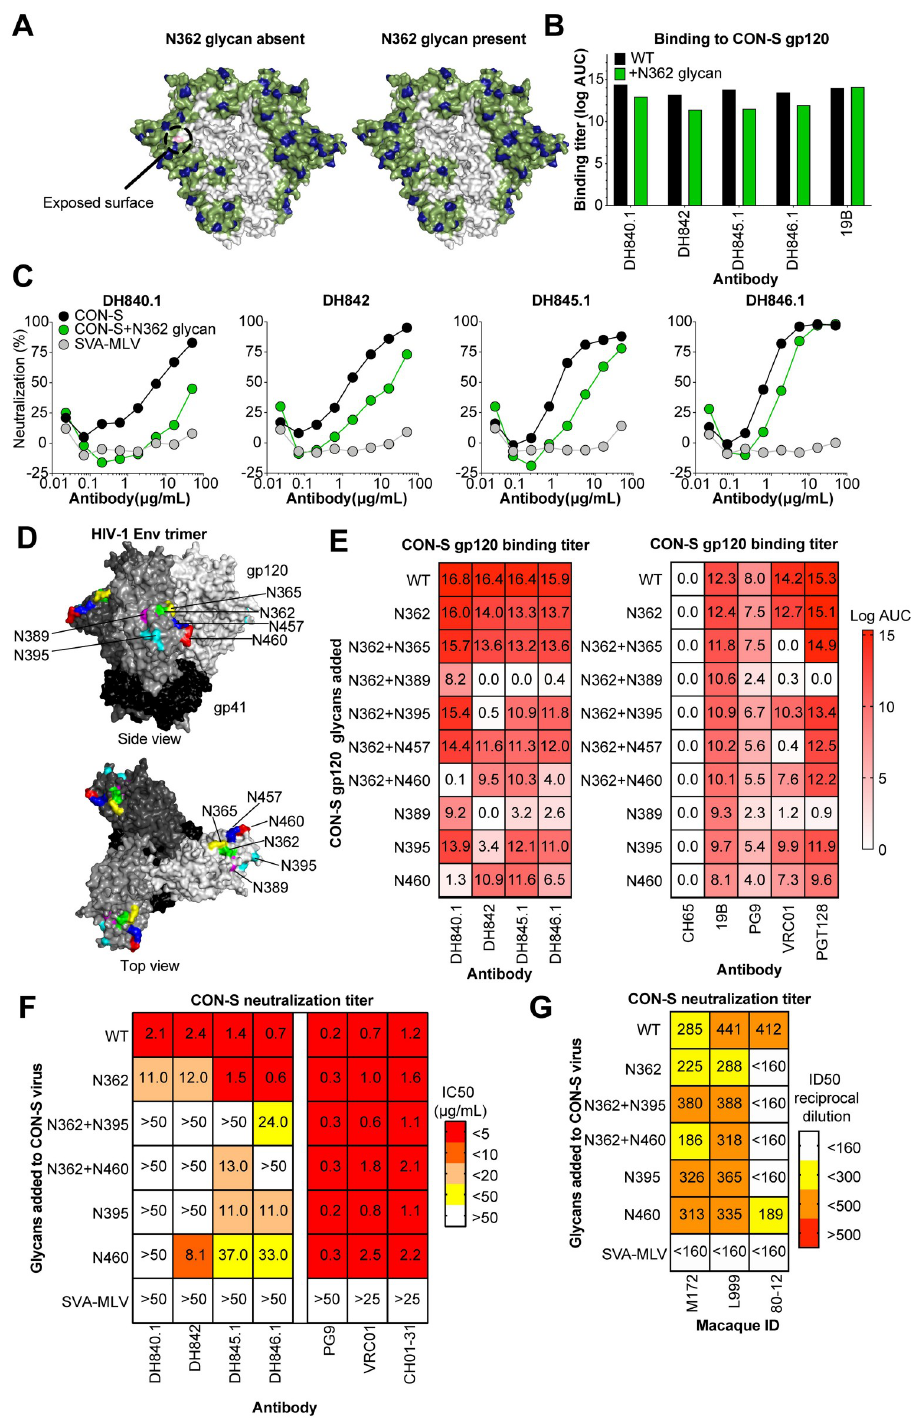
Fig 3. Hyperglycosylation of HIV-1 envelope determines vaccine-induced CON-S nAbs bind the distal side of the HIV-1 envelope gp120 subunit. (A) Computational prediction of the CON-S envelope glycan coverage of HIV-1 envelope surface using the Glycan Shield Mapping tool on the Los Alamos HIV Database (https://www.hiv.lanl.gov/ content/sequence/GLYSHIELDMAP/glyshieldmap.html). Two protomers of the trimeric envelope is shown in surface representation with potential N-linked glycosylation sites highlighted in blue. The surface potentially covered by a glycan attached to the glycosylation site is shown in green assuming 10 angstrom radius of coverage by each glycan.